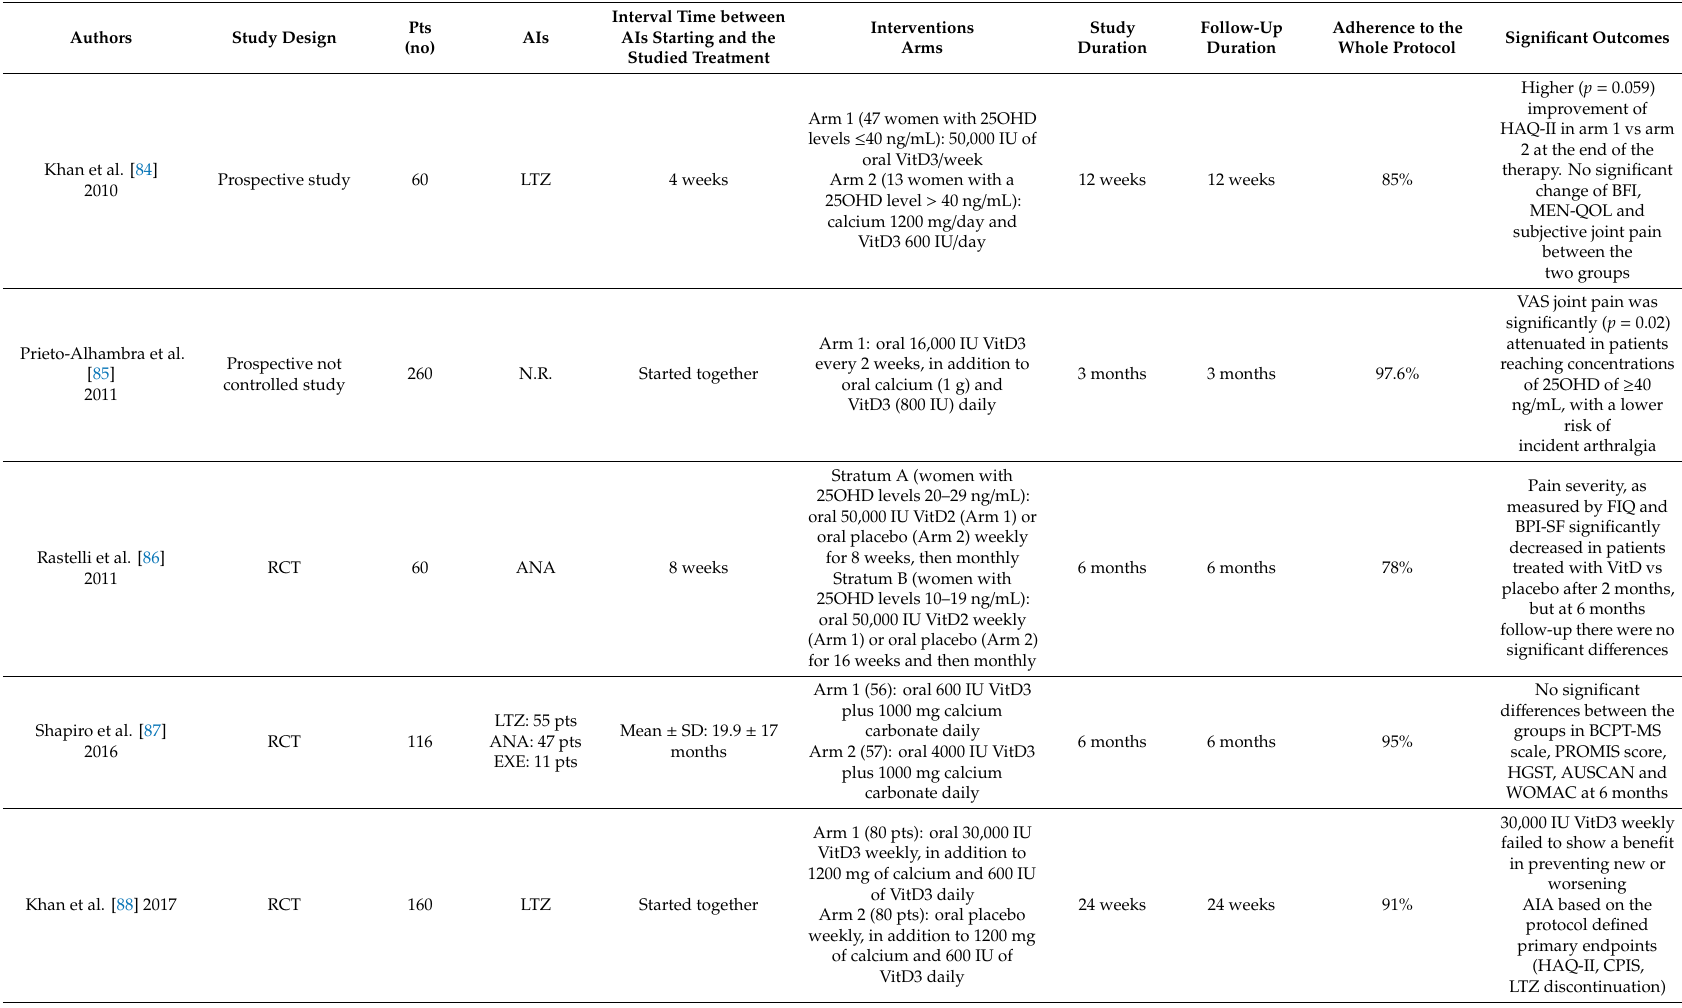
Table 2. Characteristics of the studies analyzing di ff erent pharmacological interventions for Aromatase Inhibitors-associated arthralgia (AIA)